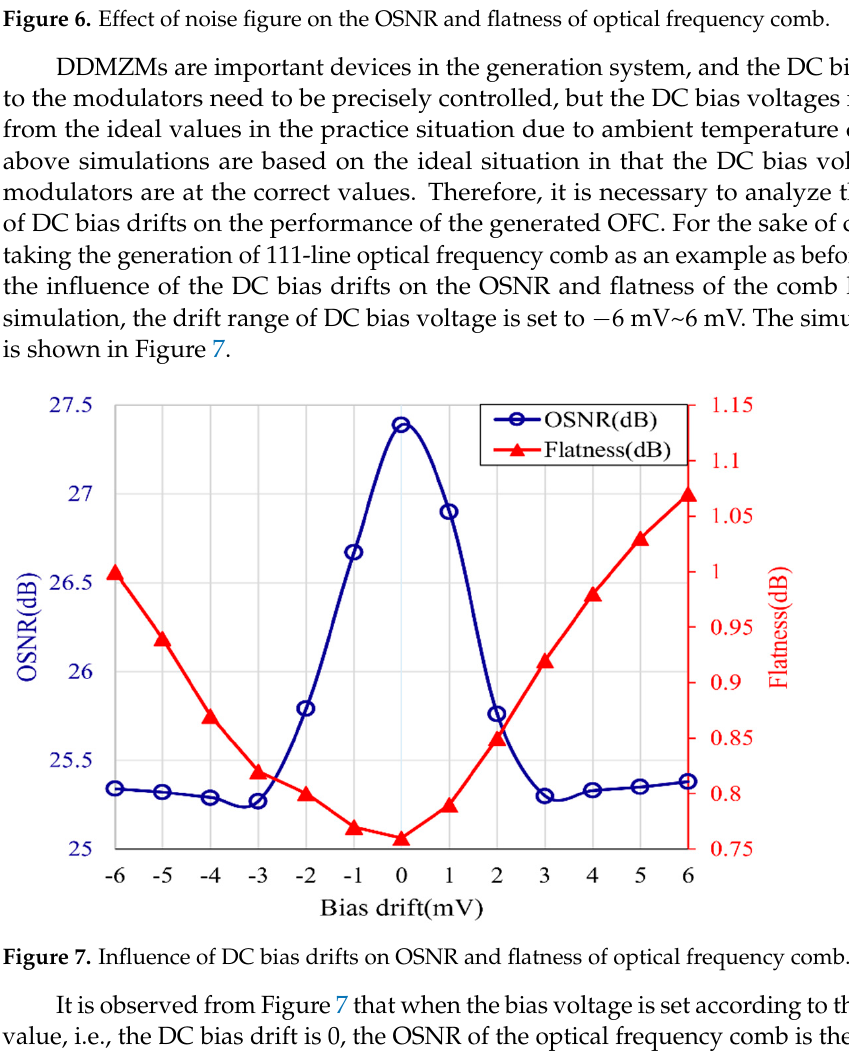
Figure 7. Influence of DC bias drifts on OSNR and flatness of optical frequency comb.